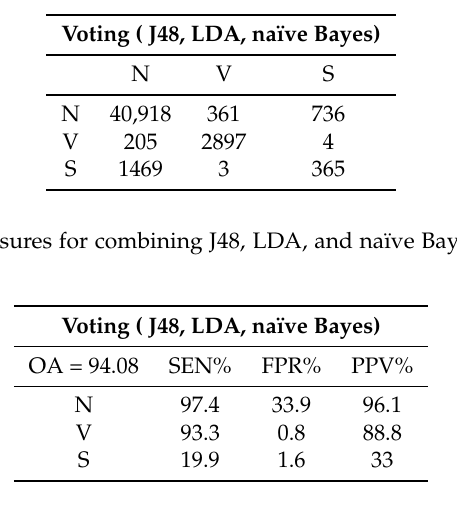
Table 20. Confusion matrix for combining J48, naïve Bayes, and QDA classifiers using Voting scheme